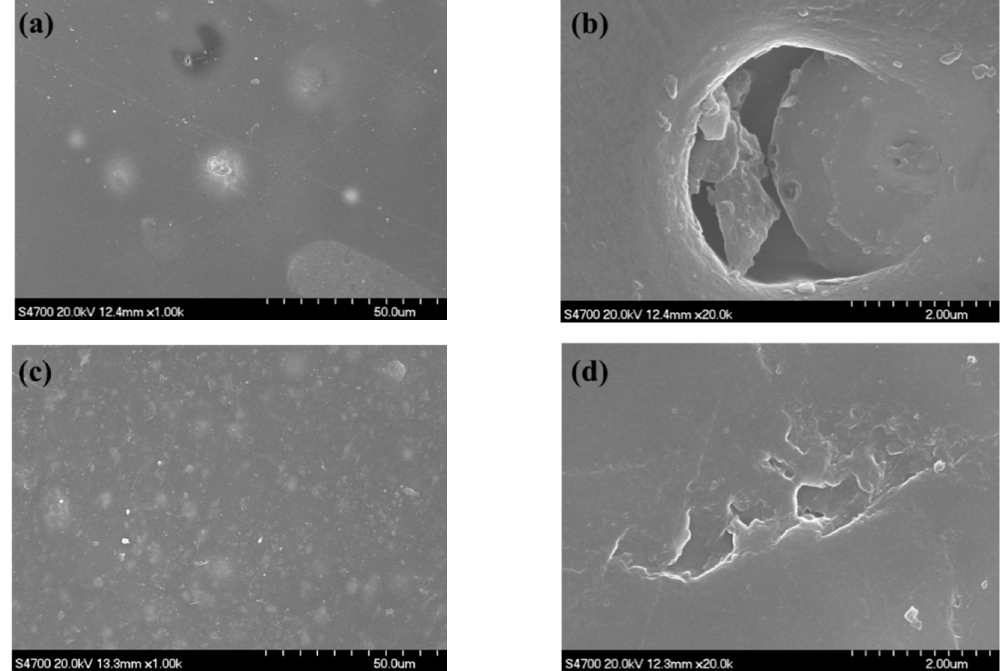
Figure 8. Surface morphology for MRP and SAP-MRP before and after exposure to the simulated acid rain solution: ( a ) surface of MRP before immersion, ( b ) surface of MRP after 339 days of immersion, ( c ) surface of SAP-MRP before immersion, ( d ) surface of SAP-MRP after 397 days of immersion.